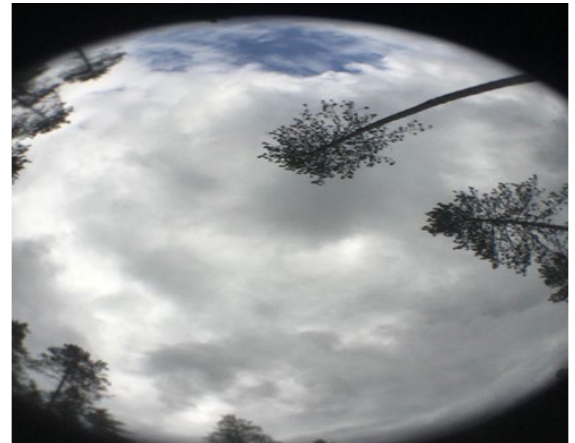
Figure 4: Crown cover photo taken with the fisheye lens mounted on a cell